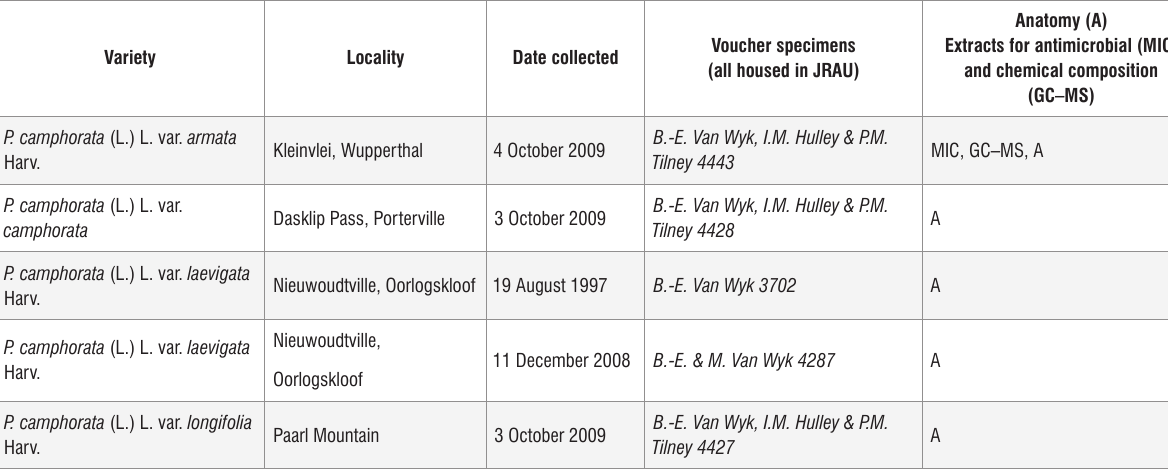
Anatomy (A) Voucher specimens Extracts for antimicrobial (MIC) (all housed in JRAU) and chemical composition (GC–MS)